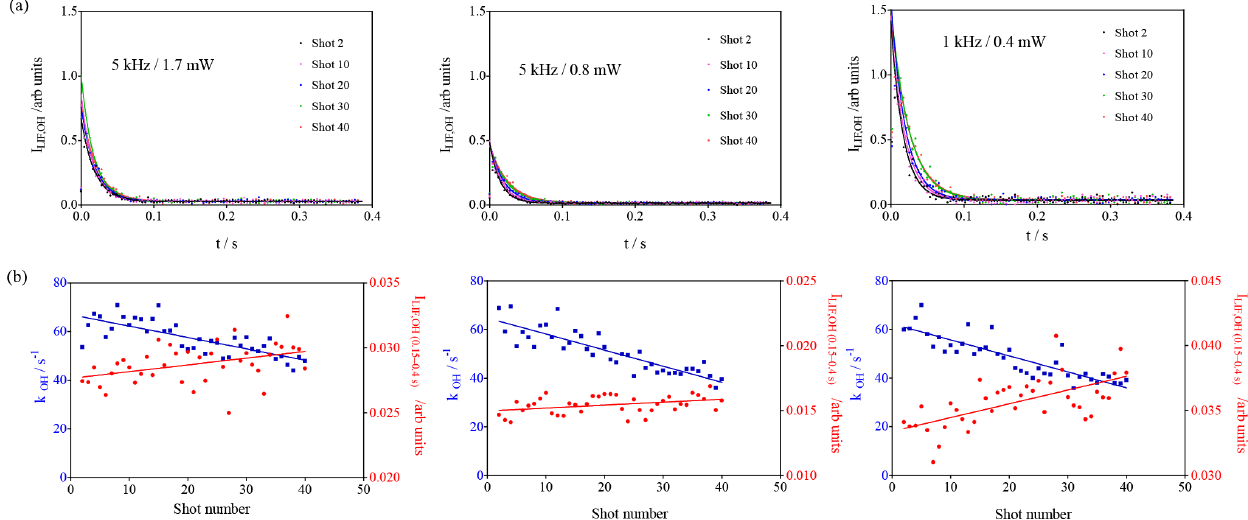
Figure 5. Photolysis of O 3 in the presence of isoprene using different excitation laser energies and repetition rates. (a) OH decays (for clarity, only every 10th decay is shown); (b) OH decay rate as a function of photolysis pulses (blue dots, left y axis) and fluorescence intensity averaged over 0.15 to 0.4s (red dots, right y axis). Table 2. Summary of results from Fig.